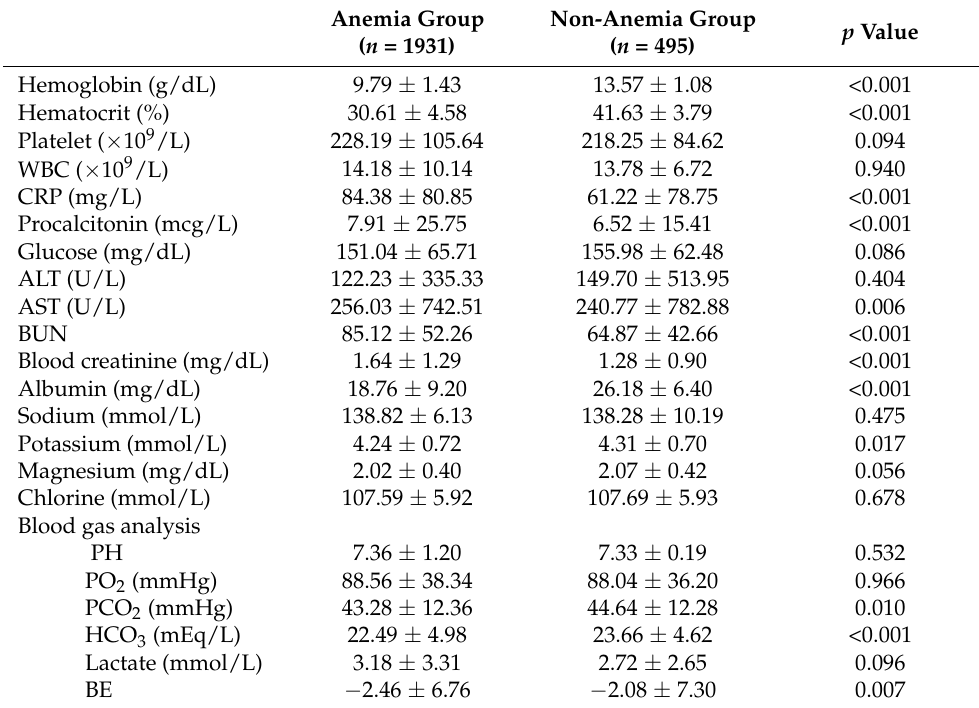
Table 2. Baseline characteristics by average laboratory parameters during the ICU